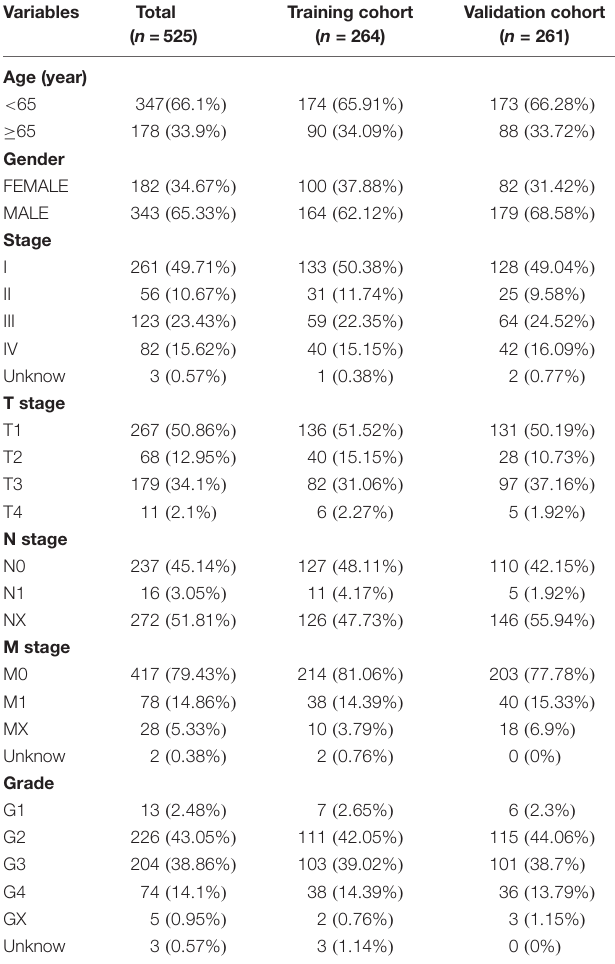
TABLE 1 | Clinical characteristics of included patients in the study.